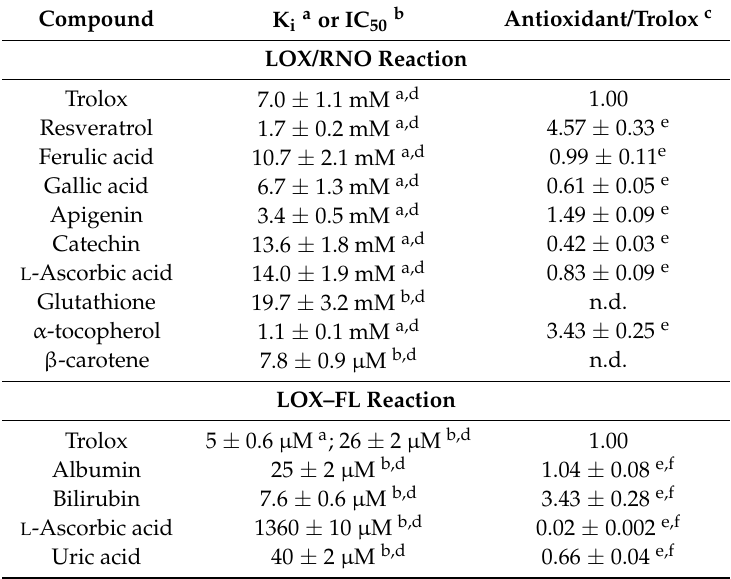
Table 2. Effects of different antioxidant compounds on LOX/RNO and LOX–FL